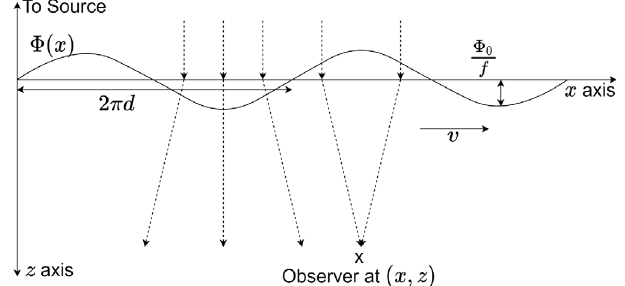
Fig. 3. A schematic diagram of the model, showing the co-ordinate system and several parameters. Dashed arrows represent raypaths for a given